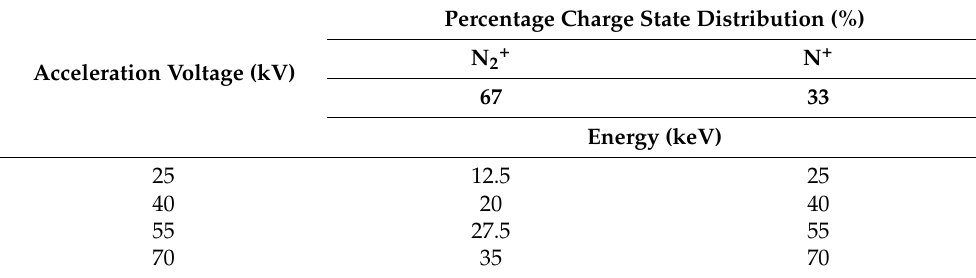
Table 1. The information about the values of the acceleration voltage and the energy of the implanted ions.